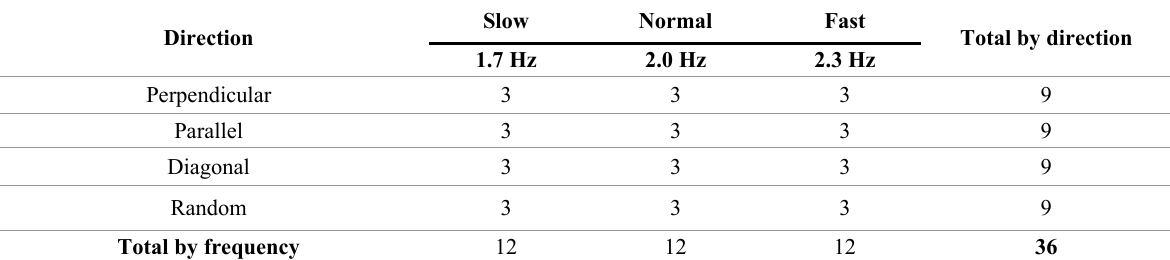
Table 1. Total tests performed per